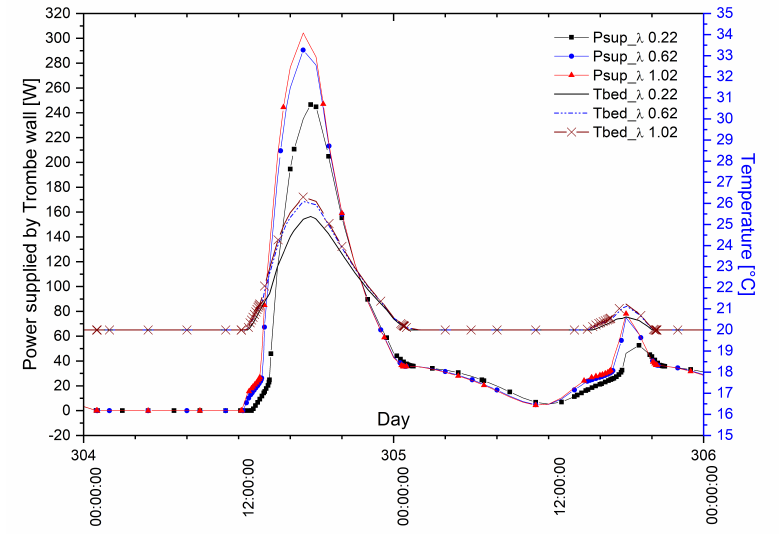
Figure 11. Effect of PCM thermal conductivity on both the power released by the solar Trombe wall and temperature inside the